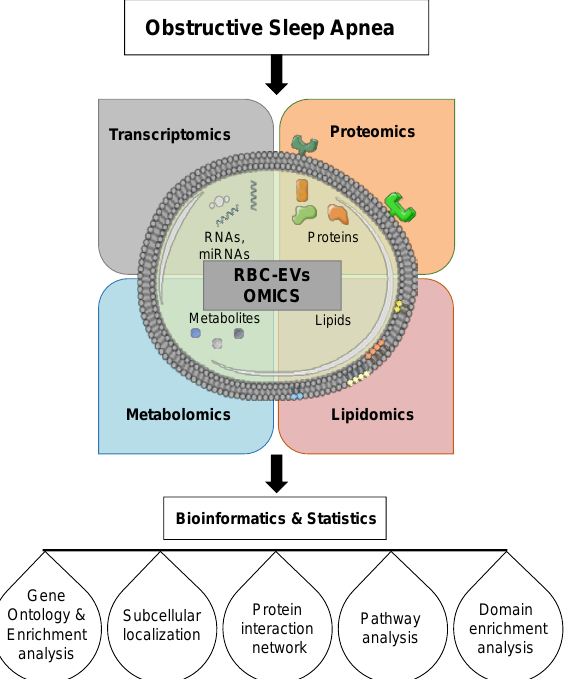
Figure 6. Schema showing RBC-EVs OMICS of OSA. Quality control techniques (NTA, TEM, and imaging flow cytometry) can be performed on the isolated EVs prior to next-generation sequencing of small RNAs and mass spectrometry of proteins. Bioinformatics can be used to identify gene ontology, protein interactions, and pathways analysis.